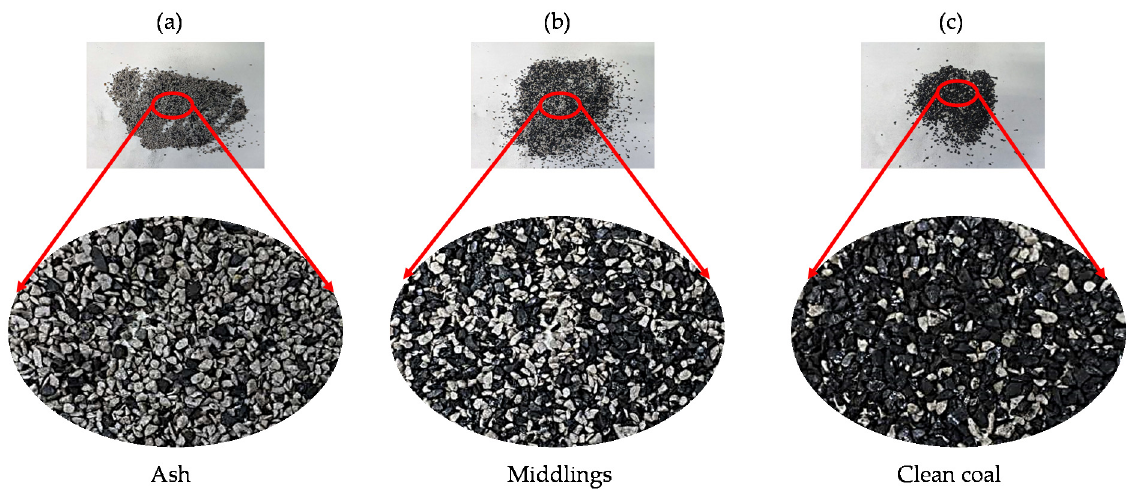
Figure 2. Different particles collected from different trays of separator: ( a ): tray numbers 1–7; ( b ): tray number 8; ( c ): tray numbers 9–12.